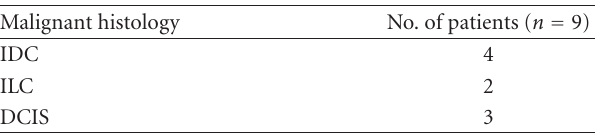
Table 2: Histologic findings of MRI-guided needle core biopsies that showed malignancy.